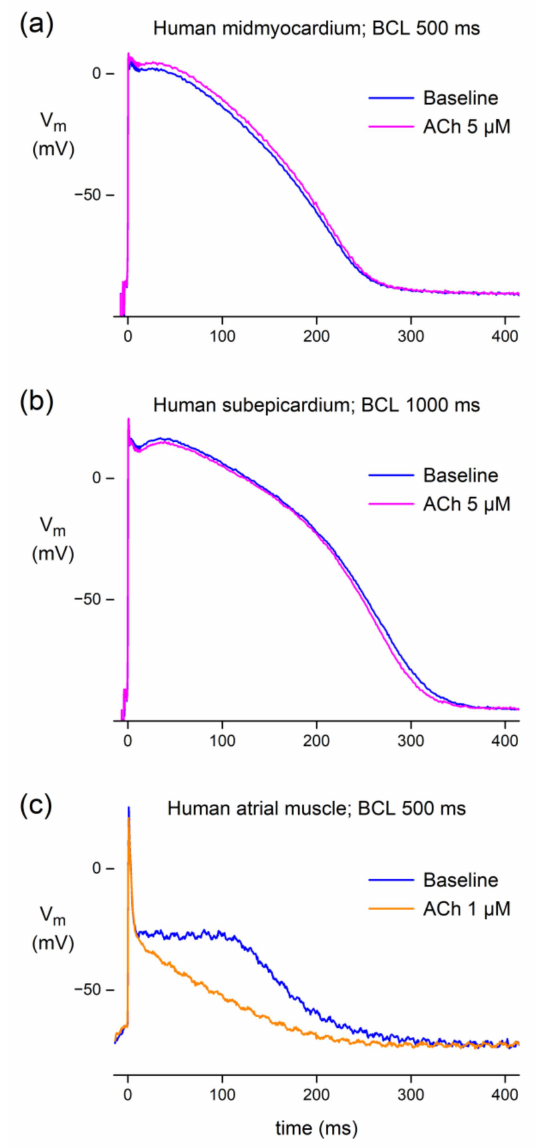
Figure 2. AP recordings obtained with microelectrode impalements of human ventricular and atrial myocardial tissue from three undiseased donor hearts. ( a ) Midmyocardial AP recording under baseline conditions and upon 5 min exposure to 5 µ M ACh at a basic cycle length (BCL) of 500 ms. ( b ) Subepi- cardial AP recording under baseline conditions and upon 10 min exposure to 5 µ M ACh at a BCL of 1000 ms. ( c ) Atrial AP recording under baseline conditions and upon 5 min exposure to 1 µ M ACh at a BCL of 500 ms. AP recordings of each panel originate from the same preparation and